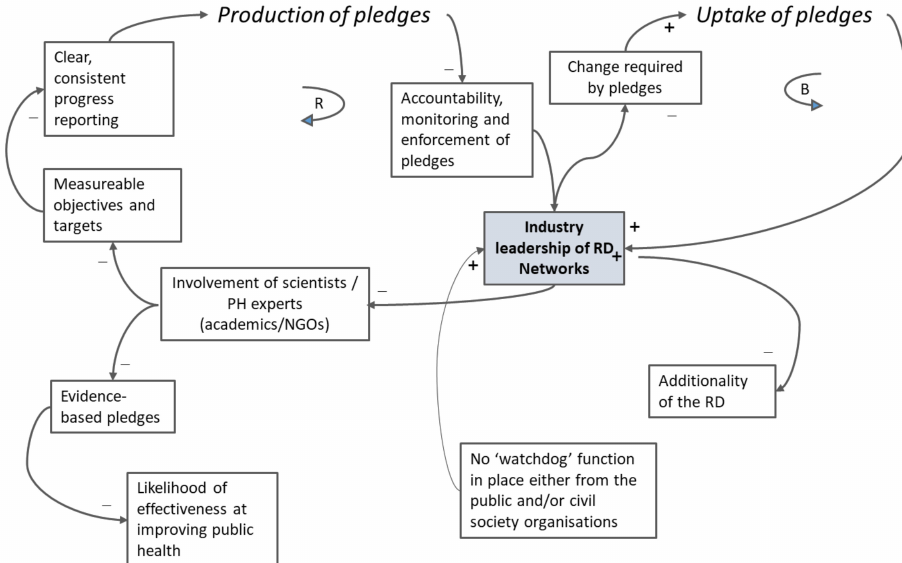
Figure 6. Causal loop diagram of the